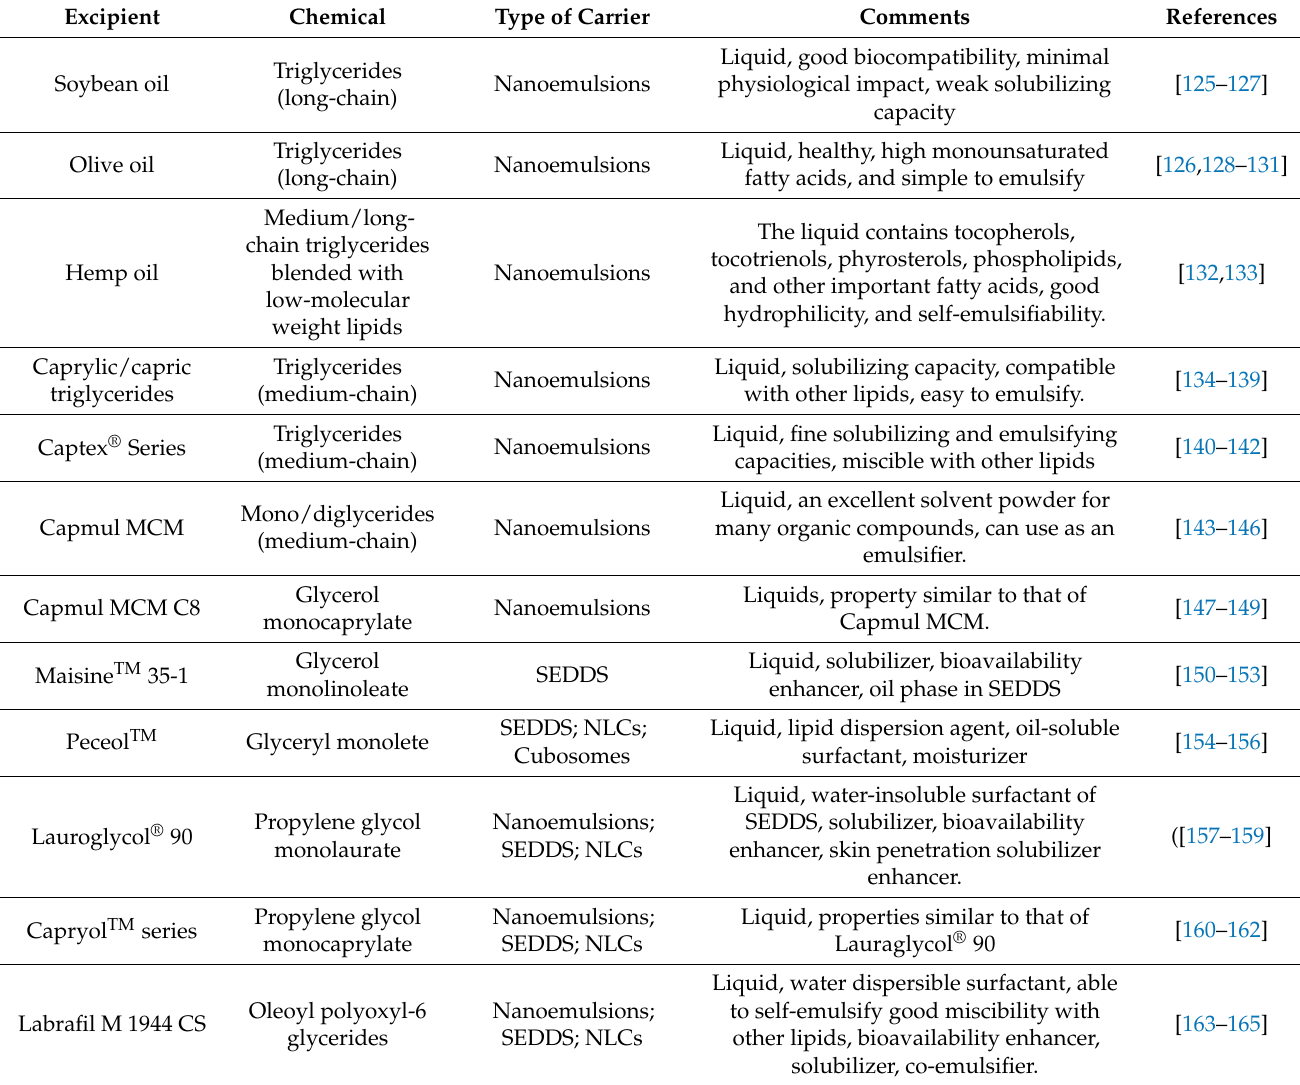
Table 9. Lipid excipients are frequently used in lipid-based